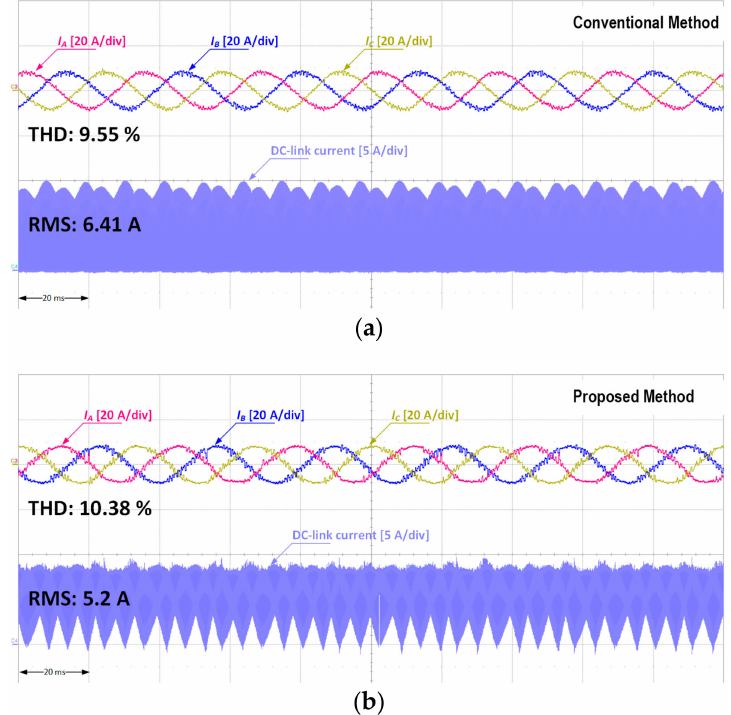
Figure 12. Experimental results for ac-currents and the DC-link ripple current: ( a ) The conventional method and ( b ) the proposed